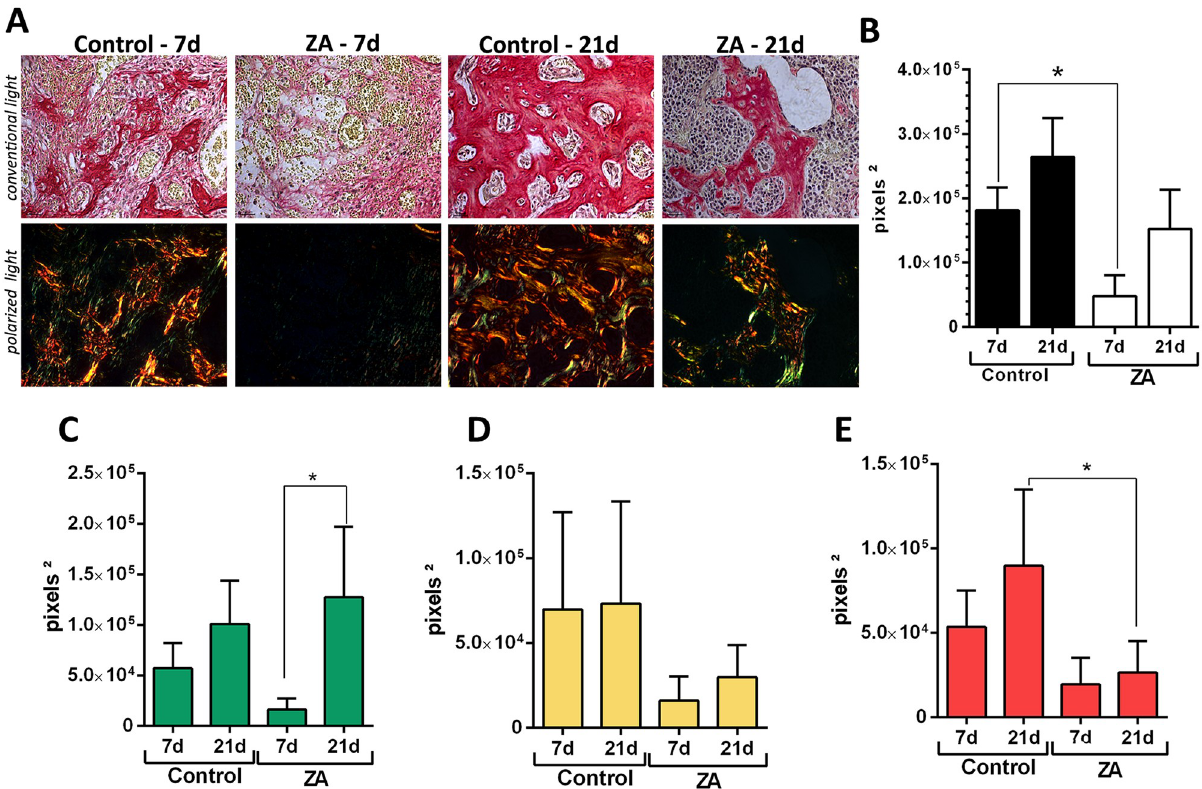
Fig 3. Birefringence analysis of collagen fibers in the alveolar sockets post tooth extraction (E sides) in control and ZA treated mice. Senescent 129 Sv-WT female mice received IP injections of 0.9% saline solution (Vehicle) or 250 μ g/Kg once a week and upper right incisor were removed after 4 weeks of Vehicle or ZA treatments. Mice were euthanized for maxillary bones removal after 7days and 21days post tooth extraction. A)Representative transversal sections alveolar socket upon polarized and conventional light, to evaluate collagen fibers maturation in the different experimental groups and periods. As visualized upon polarized light, green birefringence color indicates thin fibers; yellow and red colors at birefringence analysis indicate thick collagen fibers. Original magnification was 40x. Intensity of birefringence measured from Image-analysis software (AxioVision, v. 4.8, CarlZeiss) to identify and quantify total area of collagen fibers (B) and area of collagen from each birefringence color (pixels 2 ) (C-green, D-yellow and E-red). Results are presented as mean and SD of pixels 2 for each color in the birefringence analysis. Symbol � indicates a statistically significant difference vs. control (p <